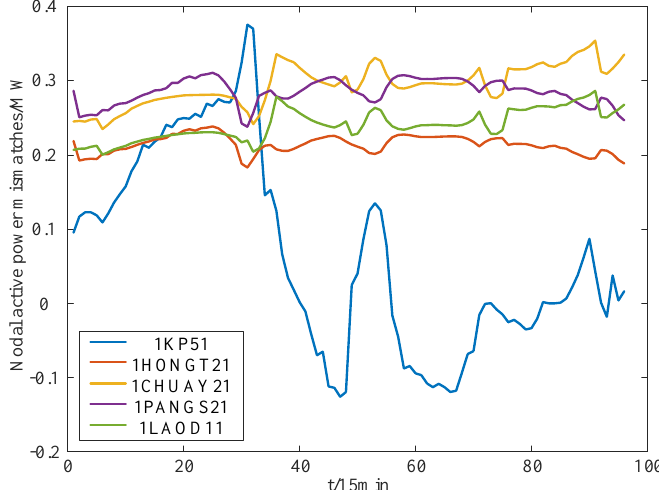
Figure 17. The five maximum nodal active power mismatches of different buses.